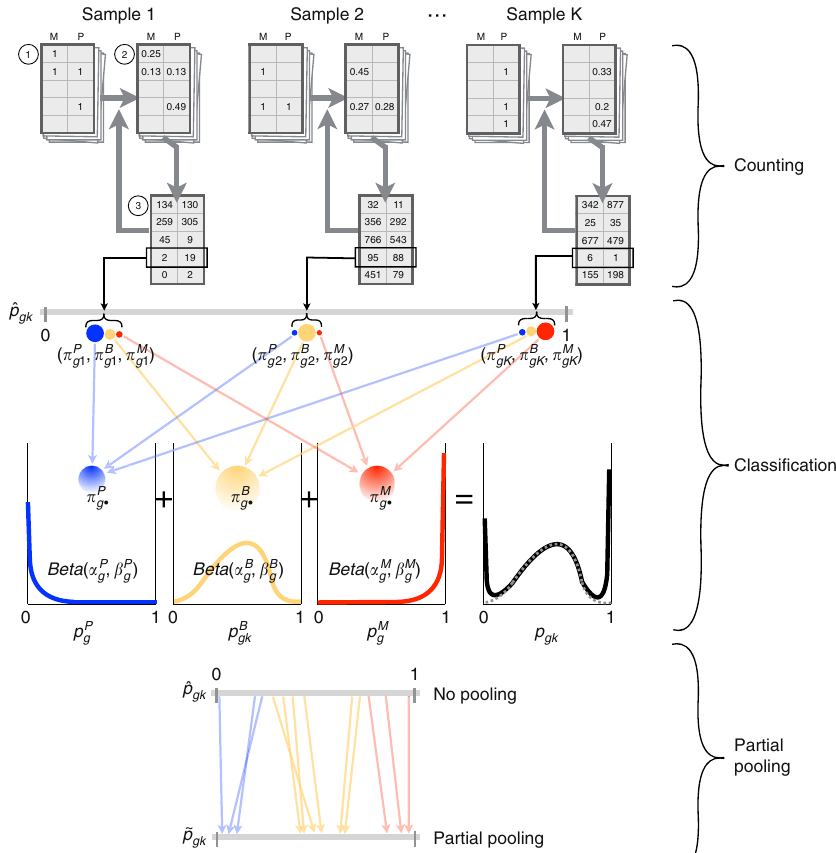
Fig. 1 Overview of the scBASE algorithm. The Counting step estimates the expected read counts using an EM algorithm to compute a weighted allocation of multi-reads. Each read is represented as an incidence matrix that summarizes all alignments to genes and alleles ① . Weighted allocation of multi-reads uses a current estimate of allele-speci fi c gene expression to compute weights equal to the probability of each possible alignment ② . The weights are summed across reads to obtain the expected read counts for each gene and allele ③ . Steps ② and ③ are repeated until the read counts converge. The weighted allocation estimates of maternal allelic proportion ( ^ p gk ) are obtained at this step. The Classi fi cation step computes the posterior probability of paternal monoallelic (P), bi-allelic (B), or maternal monoallelic (M) expression ( π s ) using current estimates of the model parameters (Equation 3 in gk Supplementary Methods). The classi fi cation model is a beta-binomial mixture model with three components. The model parameters are initialized to non- informative values and are obtained from the partial pooling step in subsequent iterations. The partial pooling step uses the classi fi cation results to re- ; β s estimate the weights of mixture components ( π s ) and parameters of the Beta densities ( α s ) that de fi ne the distribution of the within-class the maternal g (cid:3) g g allelic proportions ( p s ). The partial pooling estimate of the maternal allelic proportions ( ~ p gk ) is obtained as an average of the class-speci fi c proportions g weighted by the class membership probabilities (Eq. 1 in